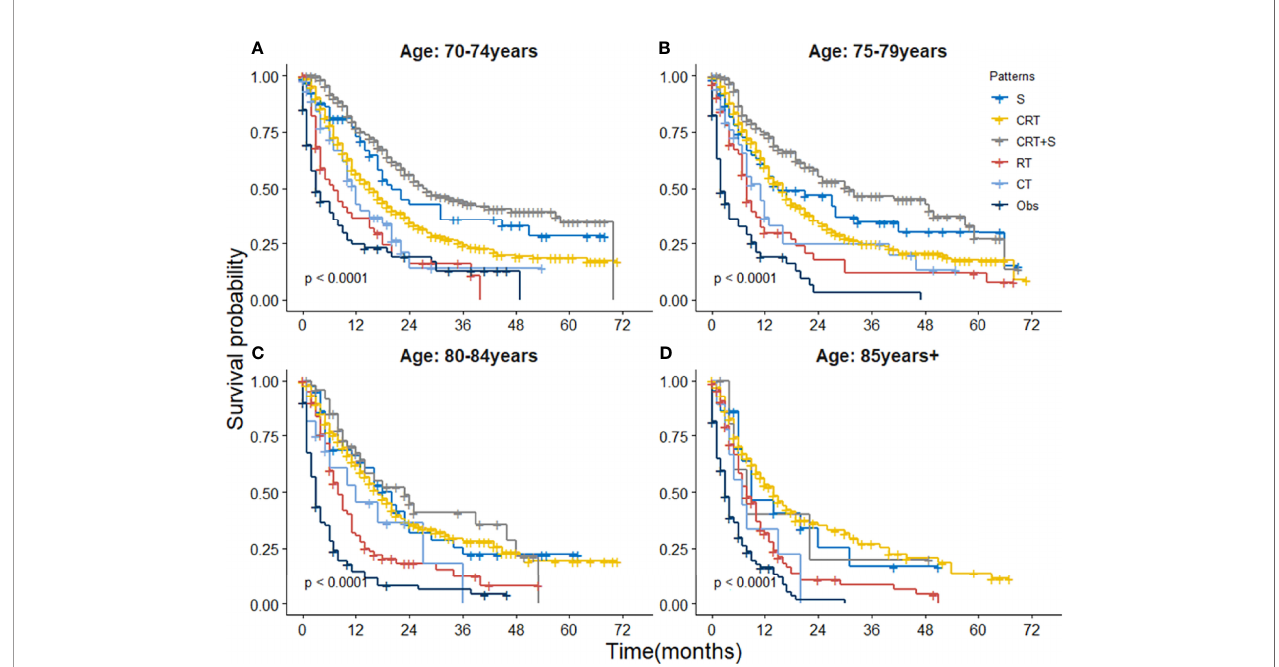
FIGURE 4 | Kaplan-Meier survival curves of OS for elderly patients with potentially curable EC strati fi ed by age group. (A) 70-74 year, (B) 75-79 years, (C) 80-84 years and (D) ≥ 85